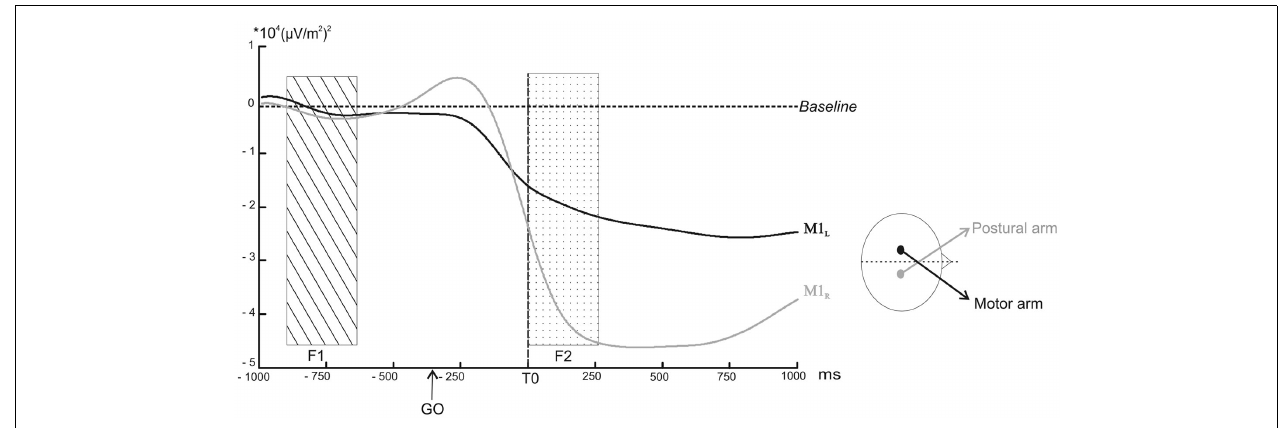
( p < 0.05).The rectangular areas indicate the two time windows chosen for the comparison of the mean amplitude (dotted rectangular area F1: from − 500 to − 300ms before the GO signal, ns; hatched rectangular area F2: from 0 to + 250ms afterT0, p < 0.05).